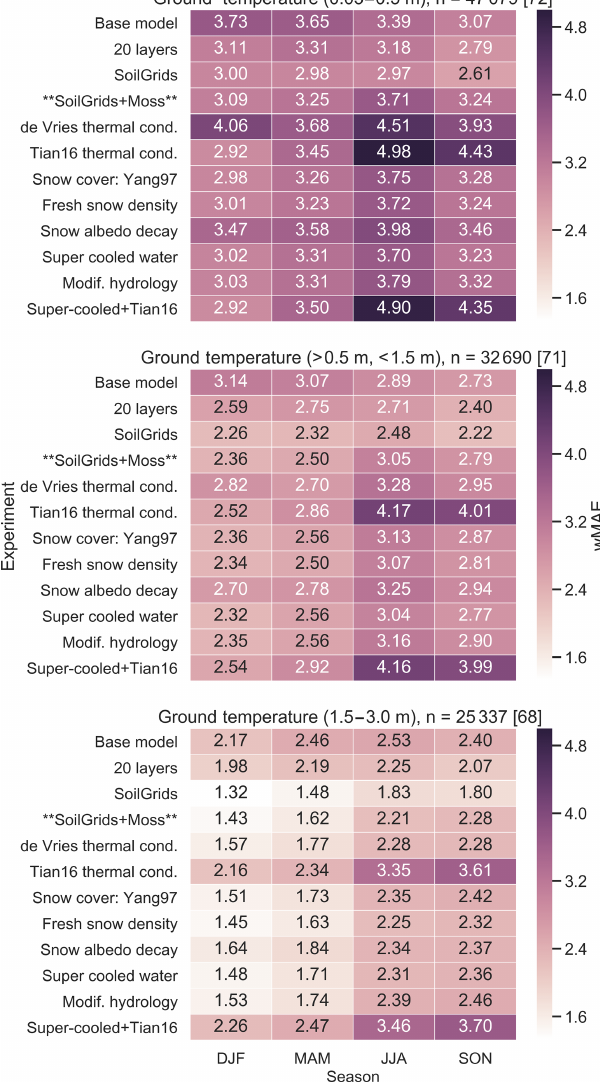
Figure 4. Weighted mean absolute error (wMAE, ◦ C) between the simulated ground temperatures and those of the GTN-P borehole temperature sites (Table S2) for three depths: 0.05–0.5, 0.5–1.5, and 1.5–3.0m. The wMAE is produced by calculating the MAE for each depth range and season at each site within a grid cell and taking the average across all grid cells (see Sect. 2.3). The num- ber of observations differs between depths and is listed along with the number of CLASS-CTEM grid cells with GTN-P borehole sites in square brackets. The color of the text annotations is purely for clarity. The wMAE of CRUNCEP surface air temperatures com- pared to air temperatures measured at the GTN-P sites is 2.17, 2.46, 2.53, and 2.40 ◦ C for DJF, MAM, JJA, and SON, respectively, over 25337 monthly